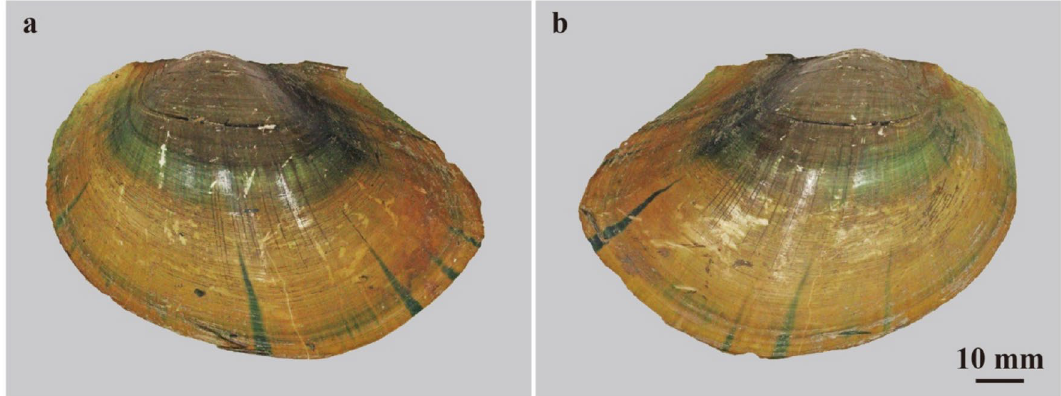
Figure 2. Color patterns of the extant freshwater bivalve Sinanodonta calipygos . ( a,b ) FPDM-I-0002924 from Lake Biwa, Shiga, Central Japan. ( a ) Left valve under normal light; ( b ) right valve under normal Data Figs. 17a,c, 18a,c, 19a,c). The radial stripes reside on the interspace of the plicated ribs on two-thirds of the posteroventral side of the shells and extend from the ventral shell margin to the median shell. In † P . naktongensis having elongated elliptical shells with radial plicated ribs and growth lines (Extended Data Figs. 11, 12b,d, 13b,d, 14b,d, 15b, see Supplementary Information S1), there are more bands running along the growth lines than those in † M . matsumotoi and sinuous near the posterior plicated ribs (Fig. 1c,f, Extended Data Figs. 12a,c, 13a,c, 14a,c, 15a). Additionally, † P . naktongensis bears colored axial segments that are 2–3 mm wide and arranged radially on the anteroventral portion. In † T . tetoriensis featured by subtrigonal shells with V-shaped ribs (Extended Data Figs. 7, 8b,d, 9b,d, 10b,d, see Supplementary Information S1), five to seven 1–5 mm wide dark stripes, appear along the growth lines, whereas radial stripes are absent, unlike † M . matsumotoi and † P . naktongensis (Fig. 1a,d, Extended Data Figs. 8a,c, 9a,c, 10 a,c). Color patterns of extant freshwater bivalves.